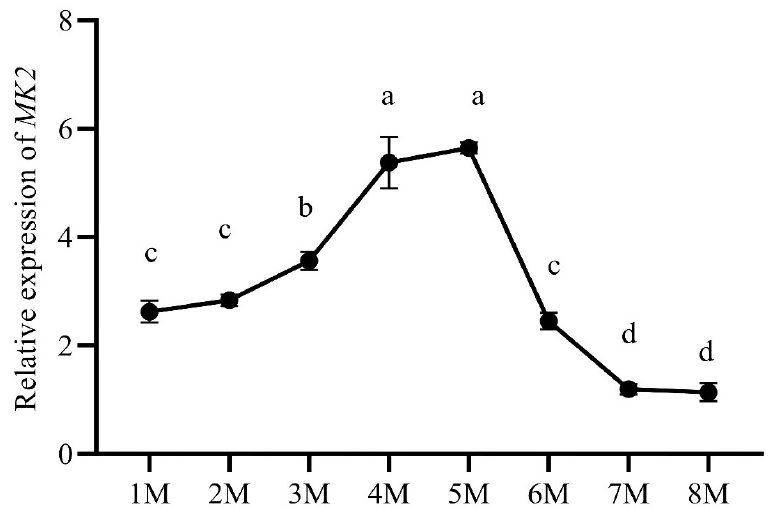
Figure 6. The relative expression of MK2 during early gonadal development in H. cumingii . The horizontal axis represents the gonadal development period (M: months). The vertical axis represents the expression of MK2 . Different letters (a–d) indicate significant differences ( p < 0.05). The same letters indicate that there was no significant difference.